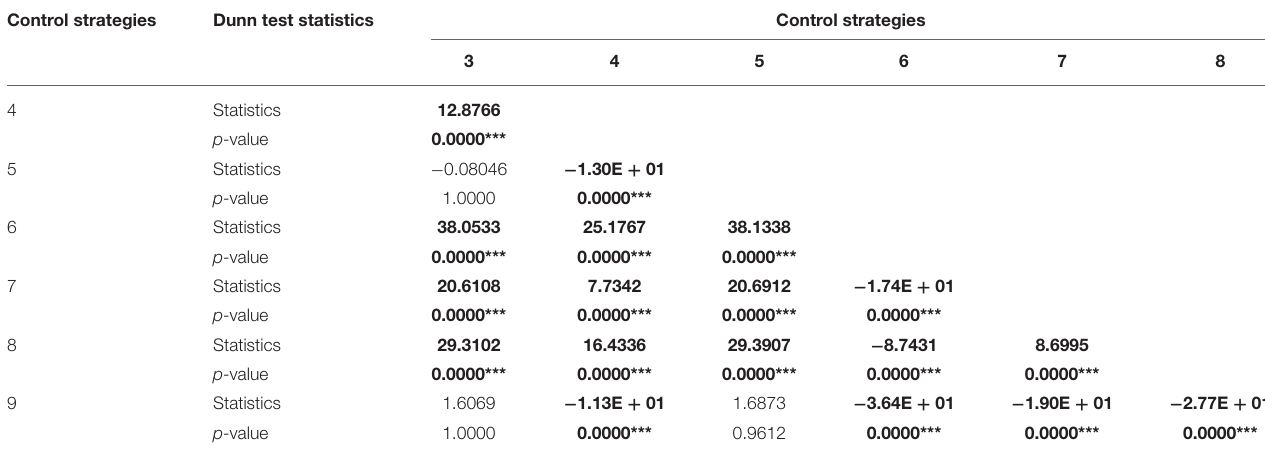
TABLE 8 | Dunn test of total animals vaccinated for Scenario VIC2. Control strategies